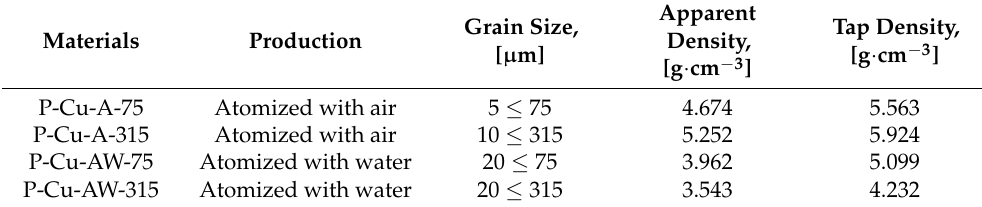
Table 1. Technical parameters of